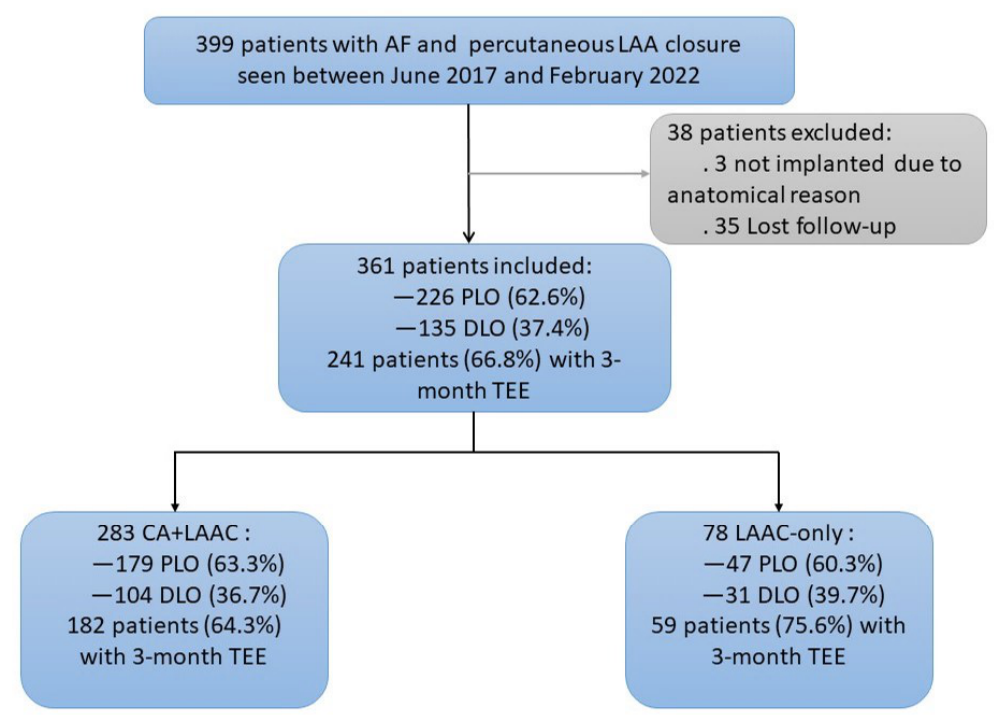
Figure 1. Flowchart of the Study